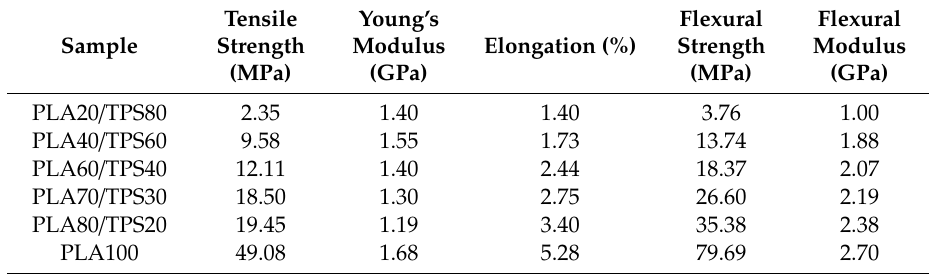
Table 5. Mechanical properties of PLA100 and PLA / TPS blend